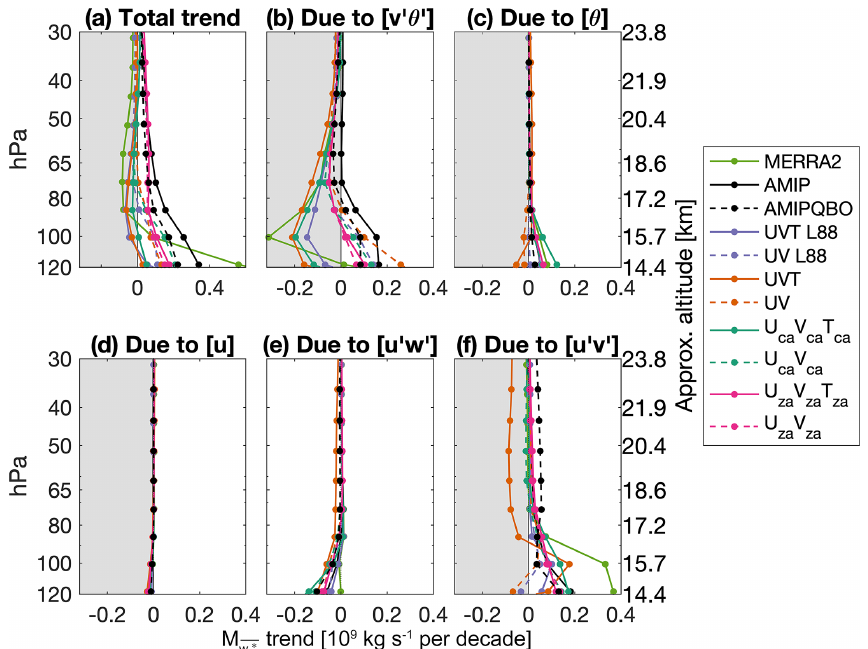
Figure 8. Tropical upwelling mass flux trend: (a) total trend, (b) trend due to the meridional eddy heat flux, (c) trend due to the zonal-mean potential temperature, (d) trend due to the zonal-mean zonal wind, (e) trend due to the vertical eddy momentum flux, and (f) trend due to the meridional eddy momentum flux. See text for